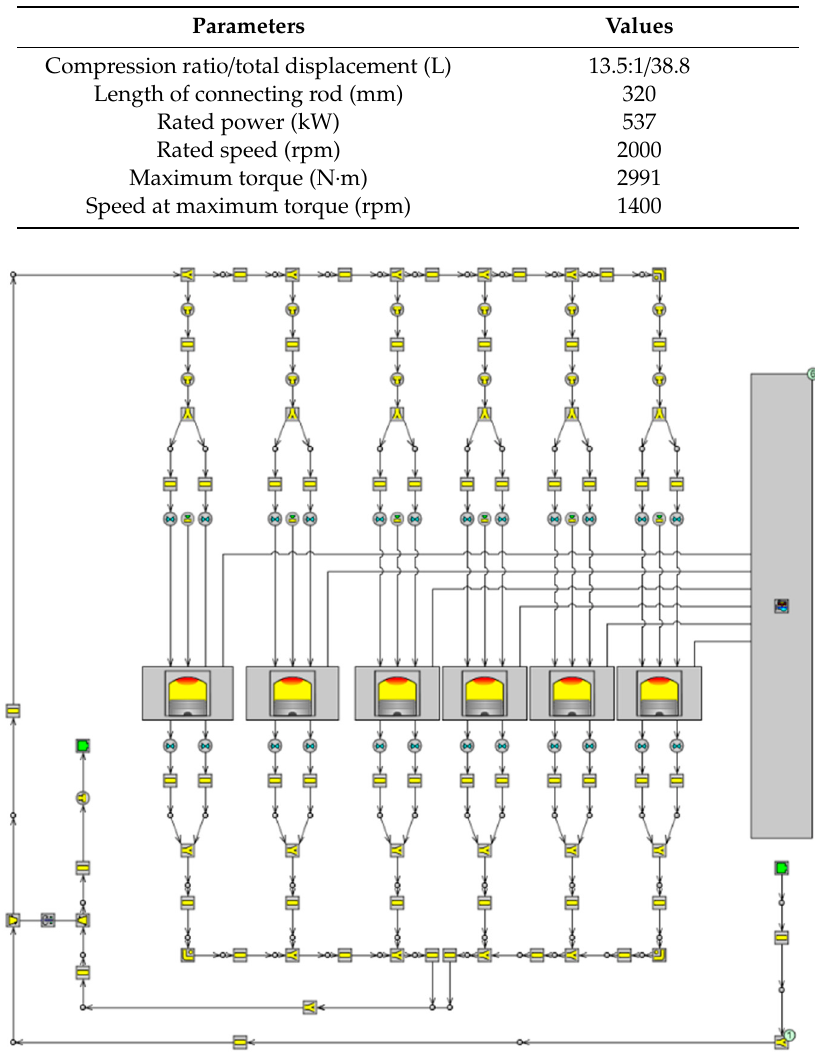
Figure 1. Simulation model of diesel engine.